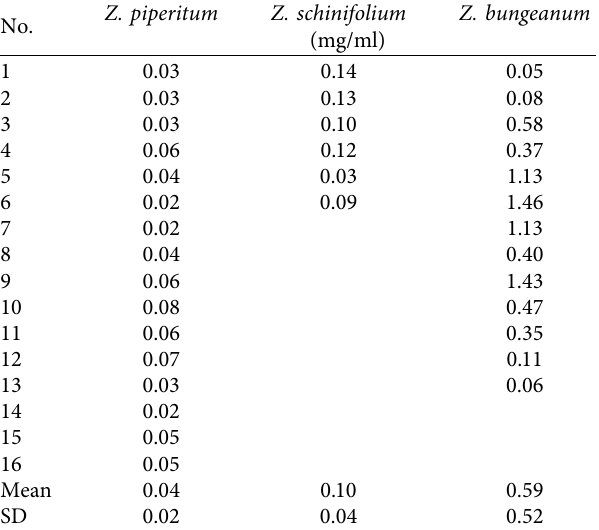
Table 2: The content of xanthoxylin for 16 elutions in three Zan- thoxylum species: Z. piperitum , Z. schinifolium , and Z. bungeanum .